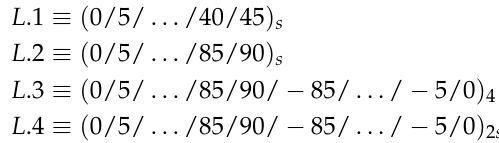
Figure 10. Stiffness coefficients k 1,1 L L / h for quasi-isotropic laminate.